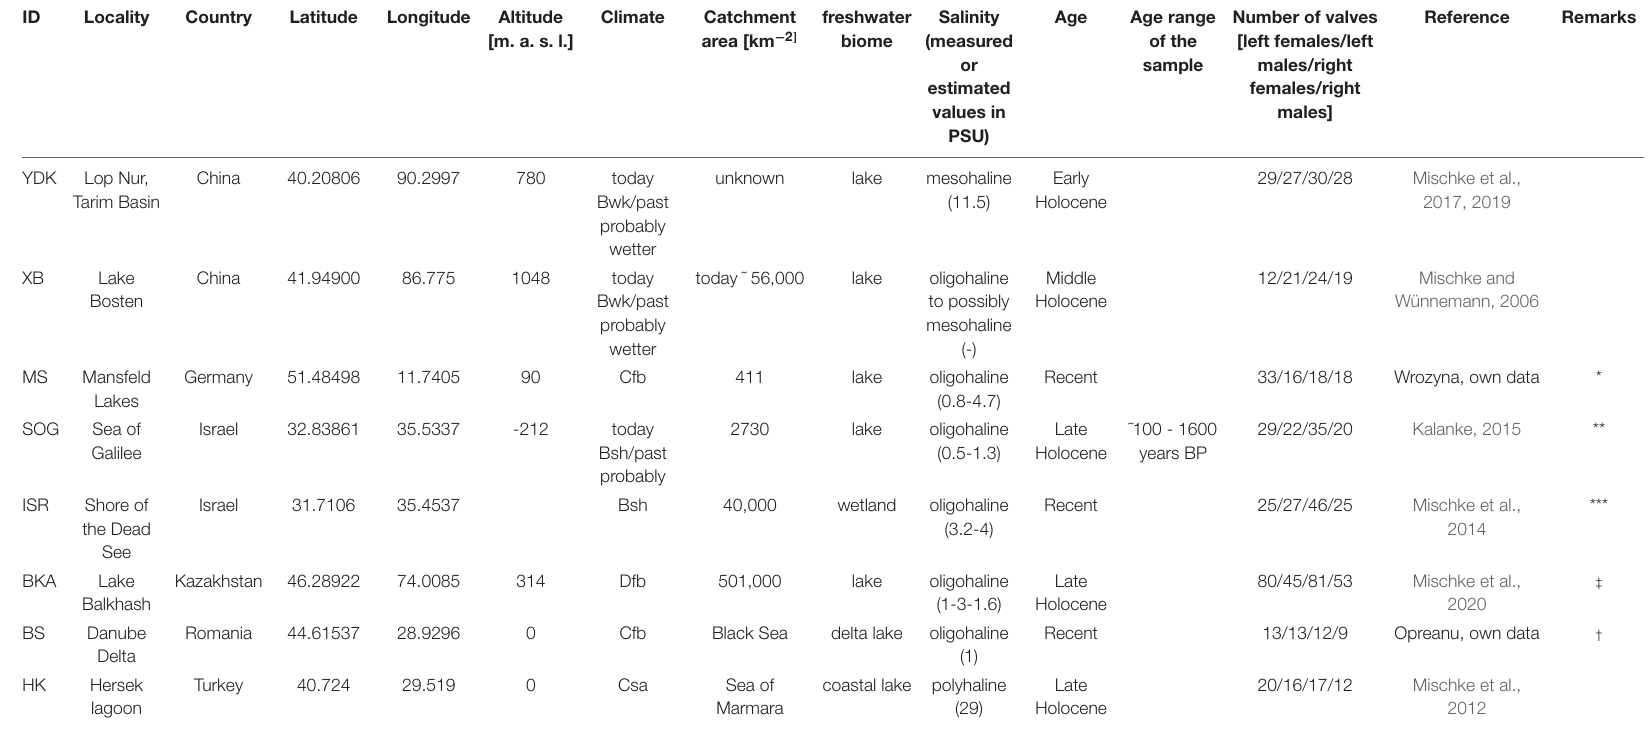
* Samples pooled from three lakes including Lake Süß, Lake Binder and Lake Kerner. ** Samples were derived from different depths of a sediment core. *** Samples pooled from 6 different localities in a wetland at the shore of the Dead Sea. ‡ Samples from a sediment core and surface sediments pooled together. † Specimens collected alive from two adjacent